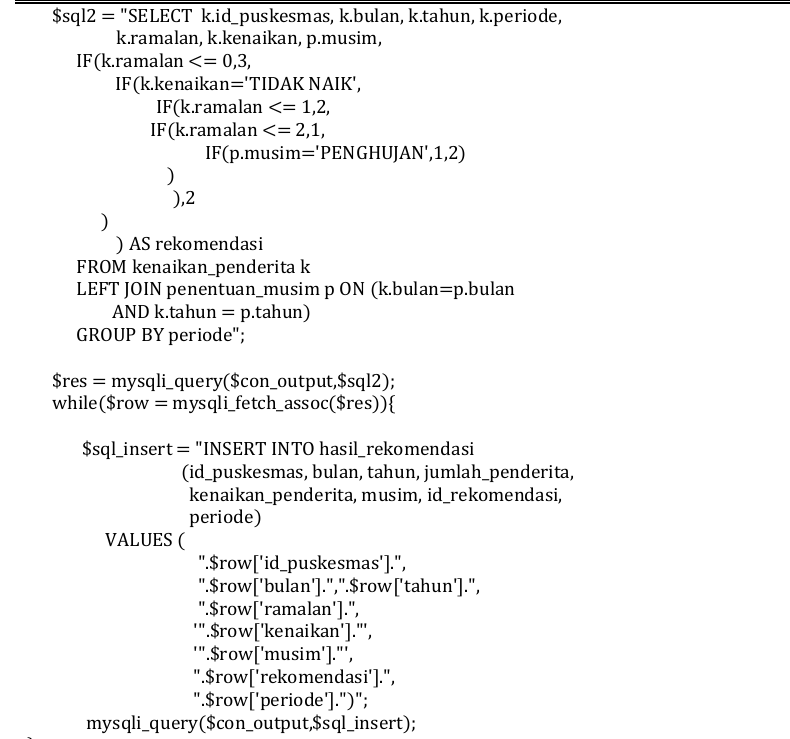
TABLE 13 SOURCE CODE OF DECISION TREE